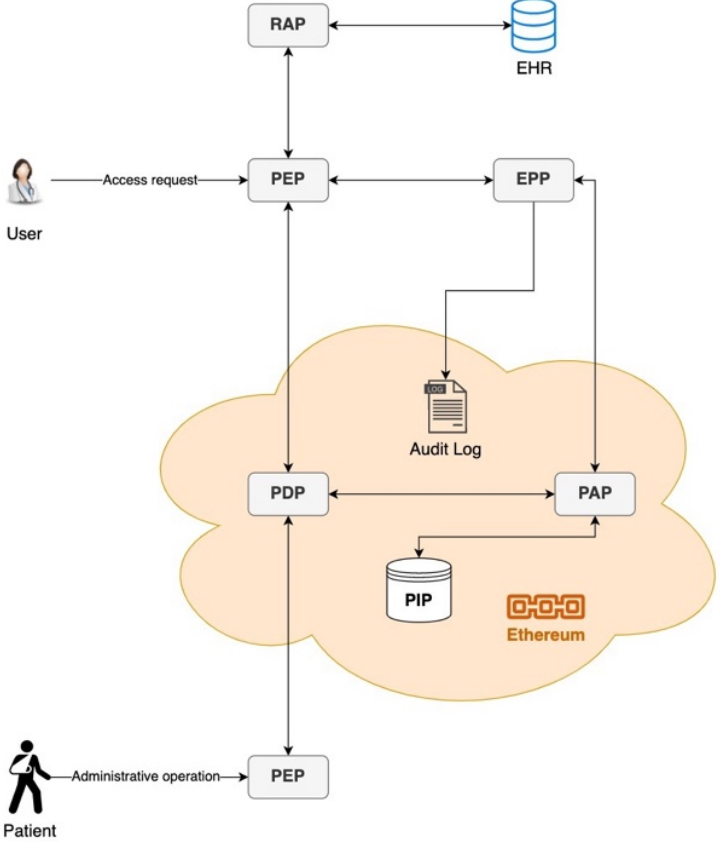
Figure 2. In-chain and off-chain deployment of NGAC components.